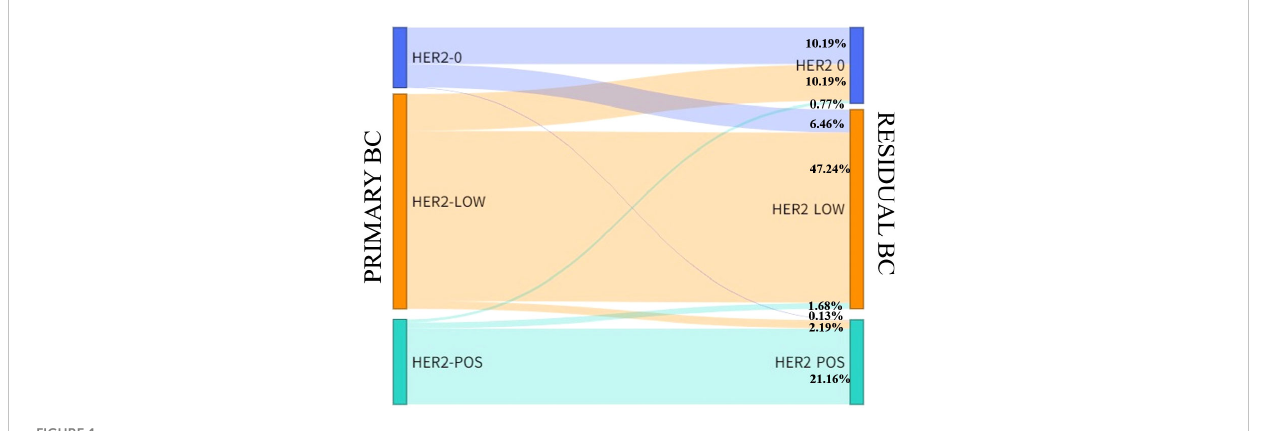
FIGURE 1 HER2 expression evolution from primary breast cancer to residual breast